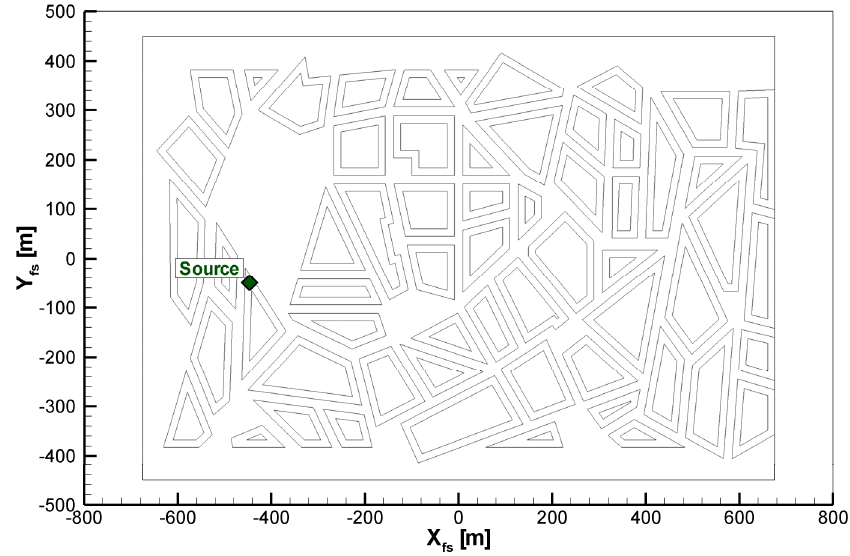
Figure 1. Layout of the Michelstadt model indicating the source location. Flow is approaching from the